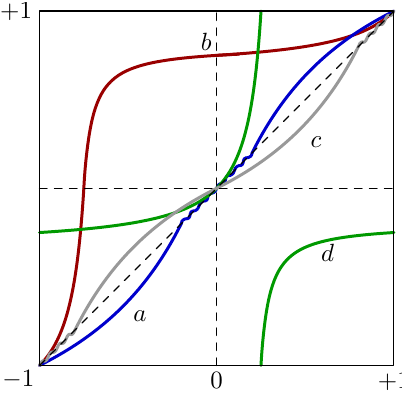
Figure 3: The action of Higman’s group on the circle S 1 ∼ = R / (cid:104) T (cid:105)